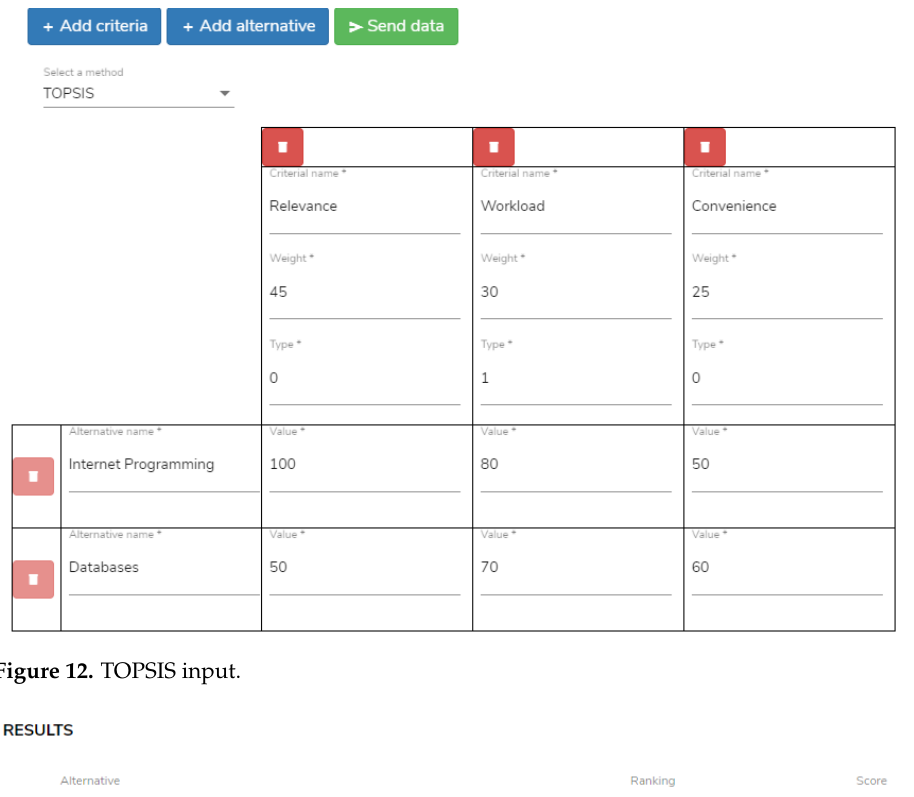
Figure 11. Results of PROMETHEE II for introducing CSS in the Databases or Internet Programming course.